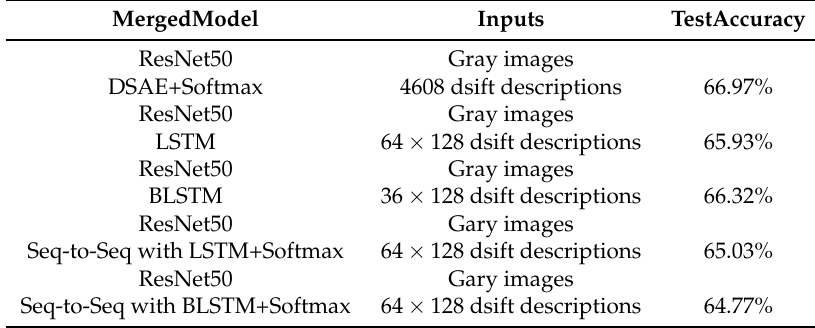
Table 7. The accuracy rates of the RAF Compound test set based on model ensembling between ResNet50 trained on spatial domain images and models trained on densesift descriptions.